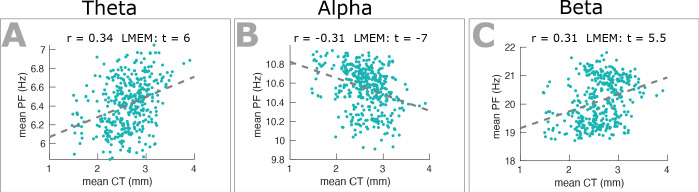
Dependency between band-specific PF and CT.Scatter plots show the relationship between trimmed mean band-specific PF and mean CT for theta (A), alpha (B), and beta (C) frequency ranges. Robust correlation was computed between trimmed mean band-specific PF and mean CT. LMEM was applied across all cortical regions defining individual band-specific PF as a function of individual CT (fixed effects) while accounting for between-individual variability (random effect). Both correlation and LMEM analyses identified a significant positive relationship for theta and beta bands but a significant negative relationship for alpha band. This analysis shows that the dependency between PF and CT is frequency specific.